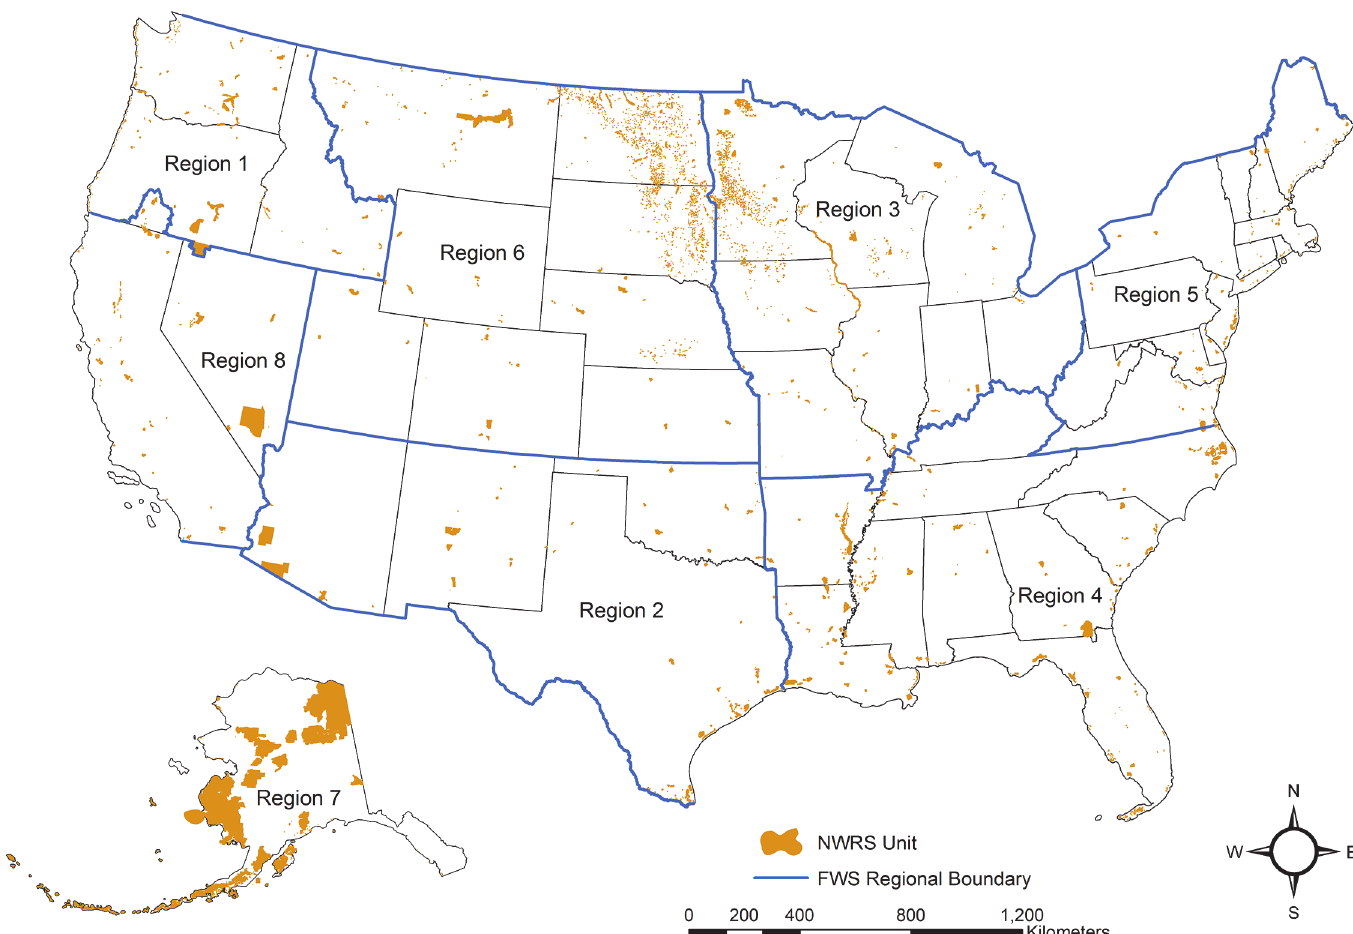
Fig 1. National Wildlife Refuges System Units in the United States. Locations of fee simple lands ( i . e . absolute title to the surface land) in the U.S. Fish and Wildlife Service ’ s National Wildlife Refuge System (includes wildlife refuges, wildlife ranges, wildlife management areas, game preserves, conservation areas, and waterfowl production areas)(NWRS Units). U.S. Fish and Wildlife Service regional boundaries are depicted with blue lines (Pacific Islands in Region 1 and Puerto Rico in Region 4 excluded).